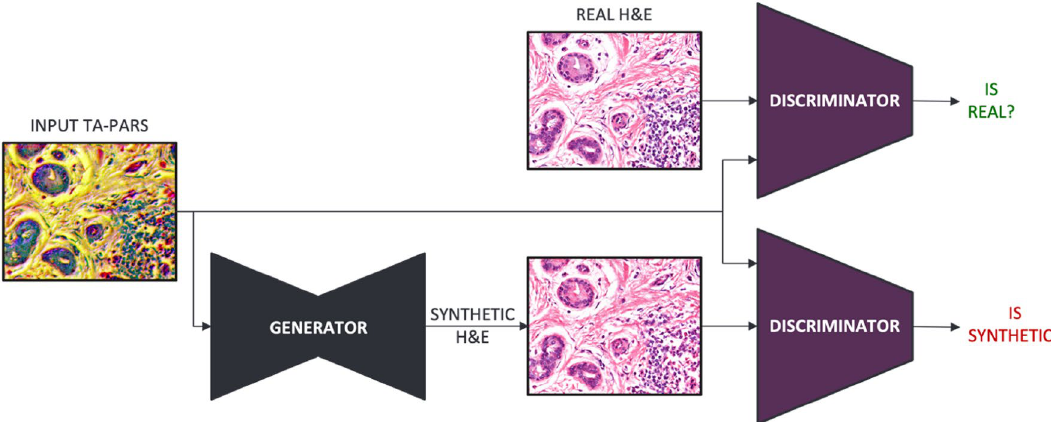
Figure 5. An illustration of the Pix2Pix training algorithm. Pix2Pix is comprised of two subnetworks: the discriminator and the generator. The discriminator subnetwork is trained to distinguish between real H&E and synthetically generated H&E. Simultaneously, the generator subnetwork is trained to confuse the discriminator by producing images that look like real